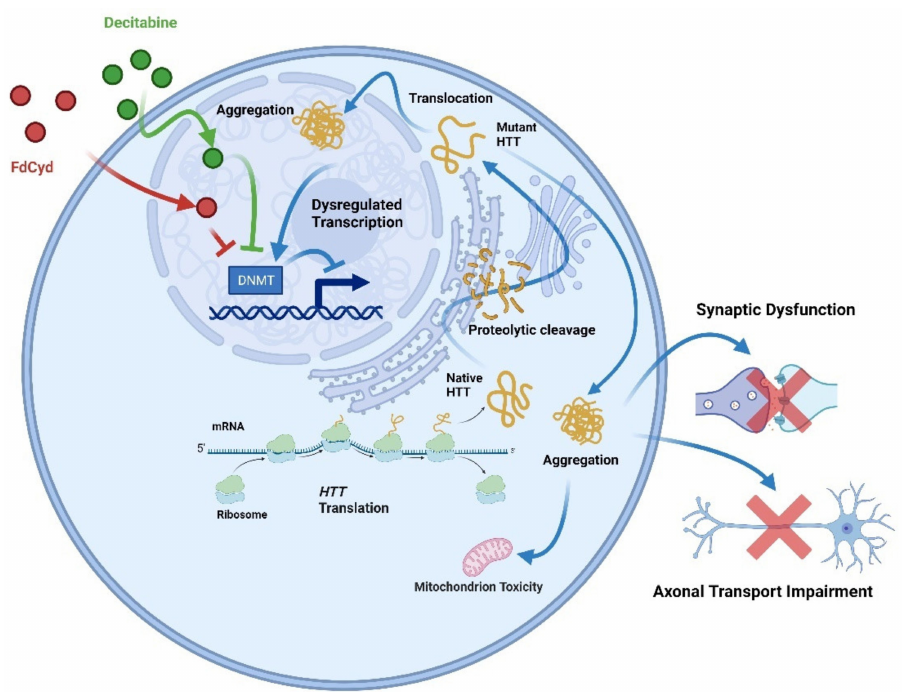
Figure 6. Inhibition of DNMTs (decitabine or FdCyd) in HD neurons blocks mutant Htt-induced transcriptional repression. The full-length huntingtin is produced by translating HTT . Proteolysis cleaves native full-length huntingtin to produce extra protein fragments, which form aggregates in the nucleus and cytoplasm. Huntingtin aggregation causes global cellular impairments, such as synaptic dysfunction, mitochondrial toxicity, and decreased axonal transport. Decitabine or FdCyd, as an inhibitor of DNMTs when administered to HD neurons, prevents the transcriptional repression induced by mutant